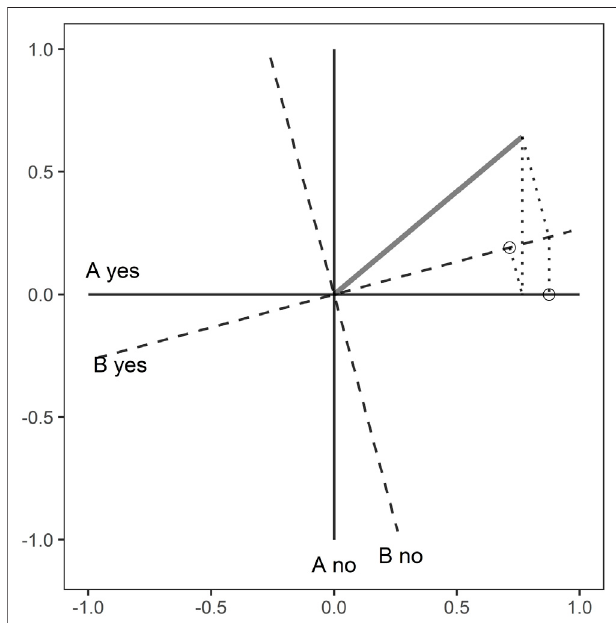
FIGURE 2 | The order effect for two questions labelled A and B. The state vector (grey line) is at an angle θ to the axes for A. The axes for B are rotated by an angle φ to those for